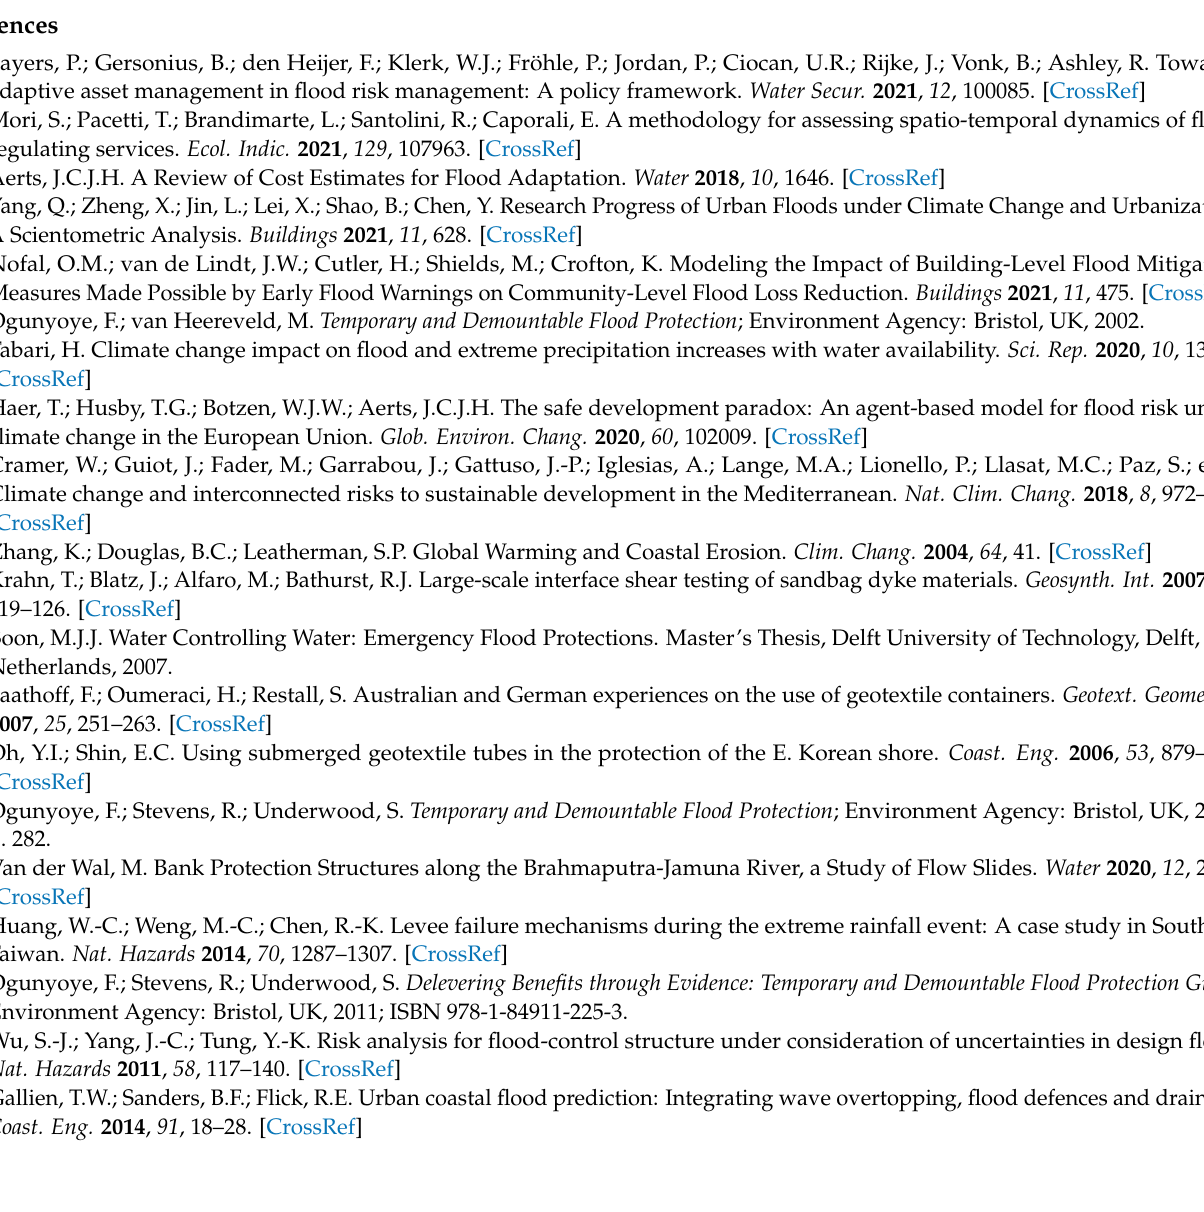
Figure A4. Panel barrier, derived from Ogunyoye and van Heereveld [6].